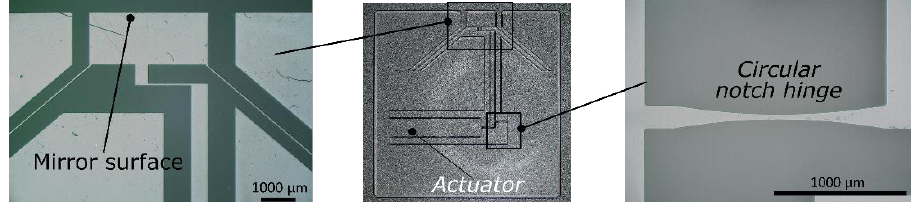
Figure 3. The fabricated device is shown here ( middle ). A digital microscope image of the mirror edge ( left ) and the notch hinge ( right ) are also shown.